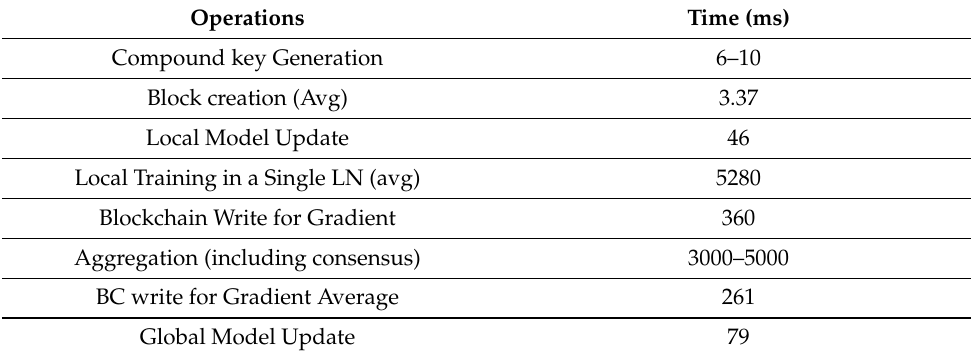
Table 3. Various execution